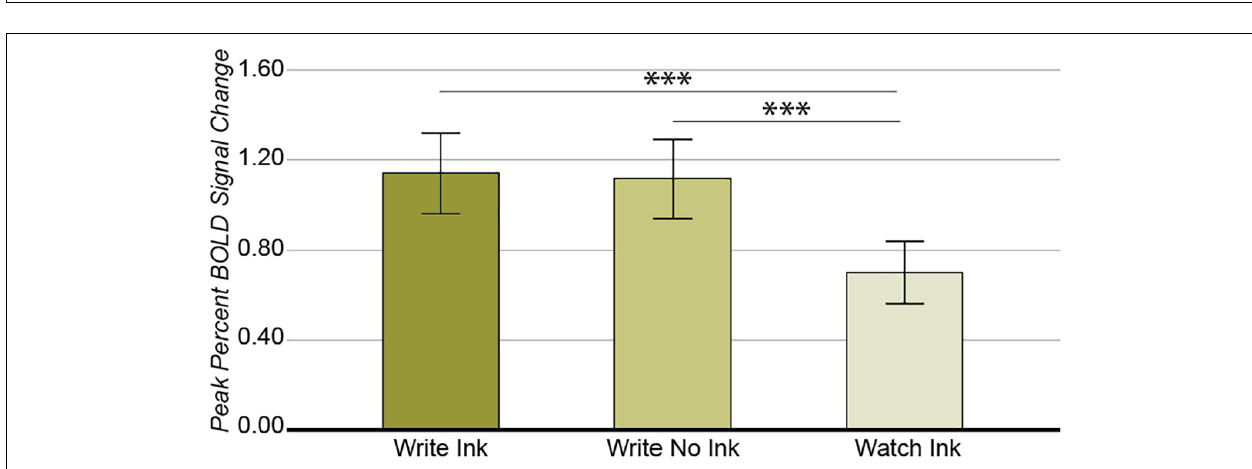
FIGURE 5 | Left anterior intraparietal sulcus. Main effect of CONDITION. Error bars represent 95% confidence intervals. ∗∗∗ p <